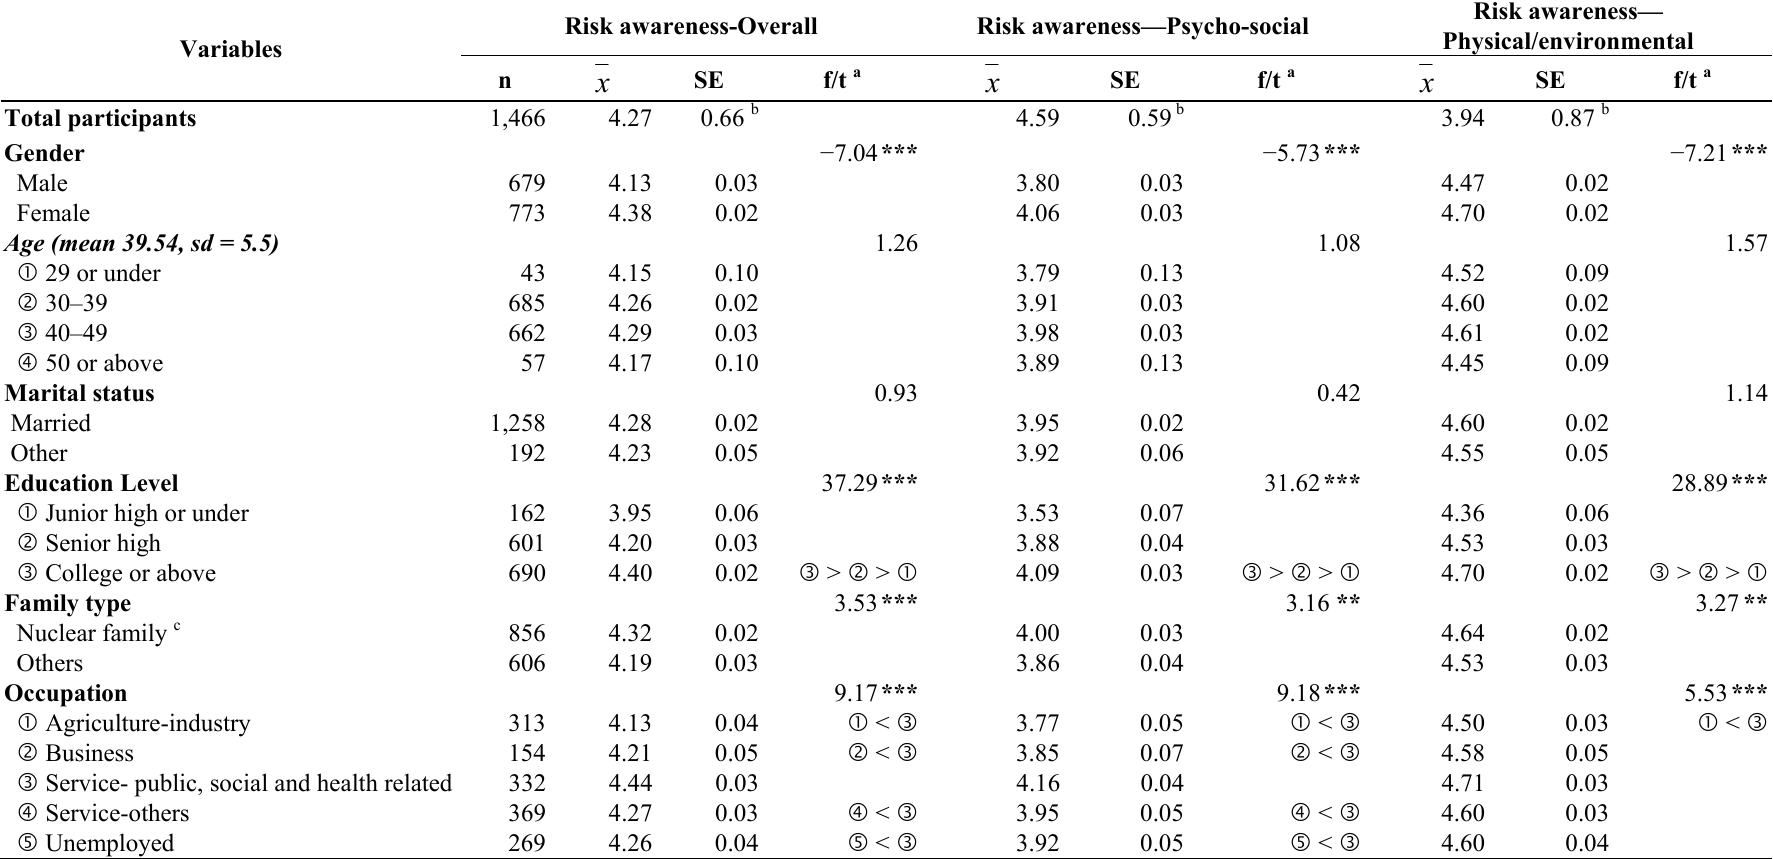
Table 2. Comparison of evaluation of the consequences of parental smoking in the presence of the children between different sociodemographic characteristics, smoking status, and agreement with having home smoking restriction (N = 1466). Risk awareness-Overall Risk Variables